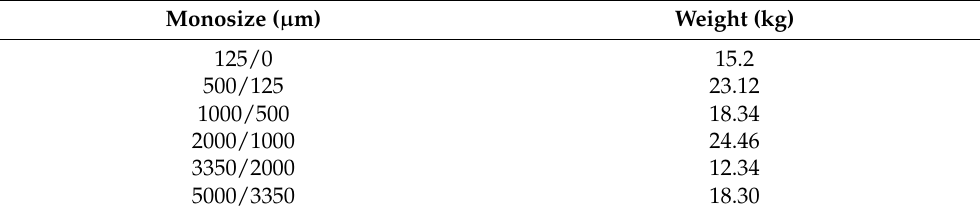
Table 2. Sample weight after preparation.